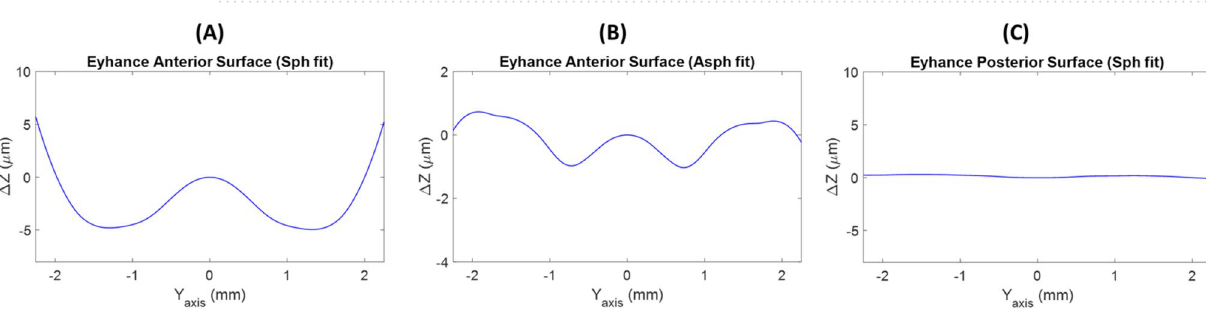
Figure 4. Subtraction lines obtained after the removal of the best-fit sphere ( A ) or asphere ( B ) of the anterior surface and the best-fit sphere of posterior surface ( C ) from the smooth profiles of the Tecnis 1 IOL.